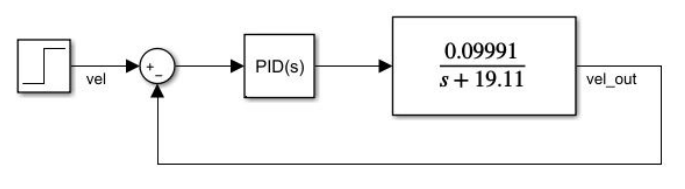
Figure 12. Motor velocity control system.